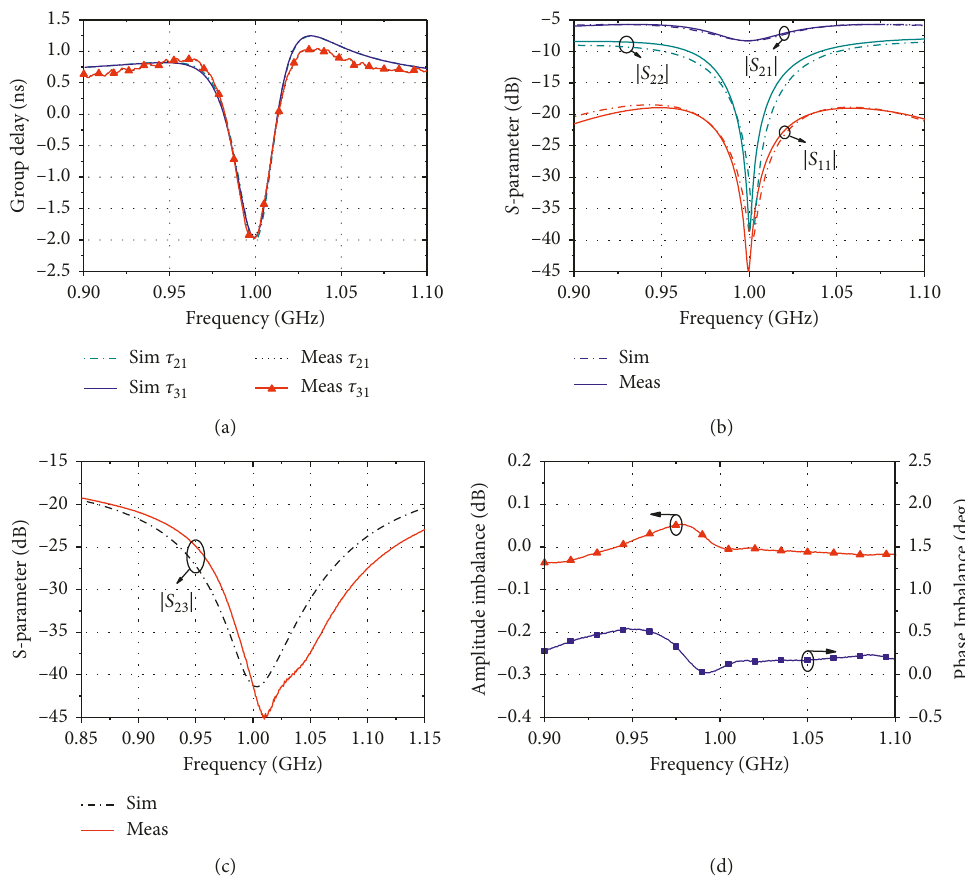
Figure 7: Performances of the proposed power divider. (a) Simulated and measured group delay. (b) Simulated and measured ILs and RLs. (c) Simulated and measured isolation. (d) Measured amplitude and phase imbalance characteristics.